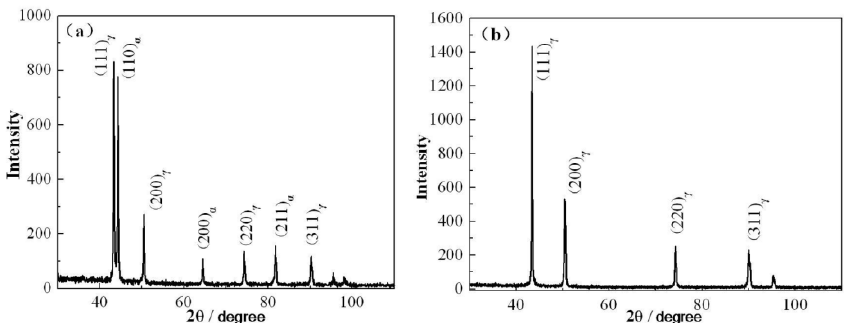
Figure 3. X-ray diffraction (XRD) diffraction analyses of the tested steel ( a ) without and ( b ) with added nitrogen.